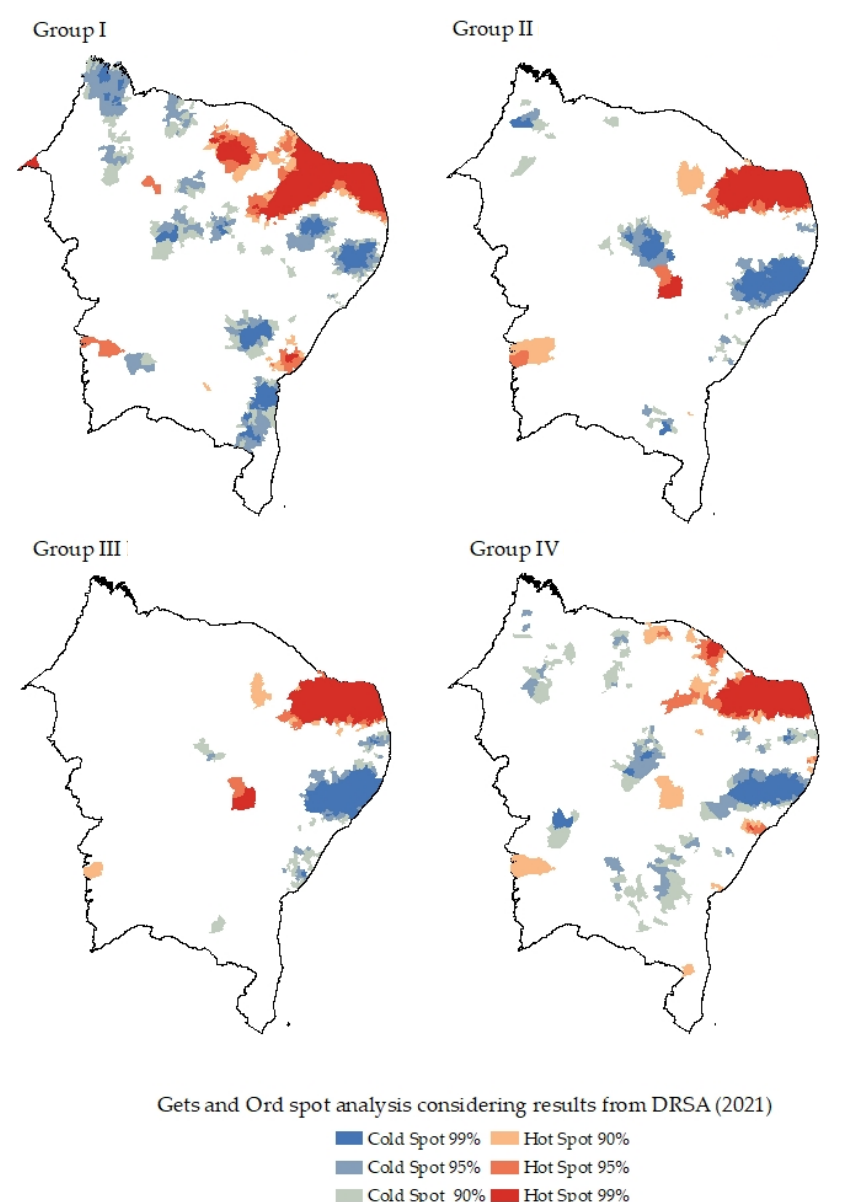
Figure 8. Getis and Ord analysis after DRSA results of cases registered in 2021. Each group describes the clusters obtained from the Getis Ord analysis applied to the year of 2020.